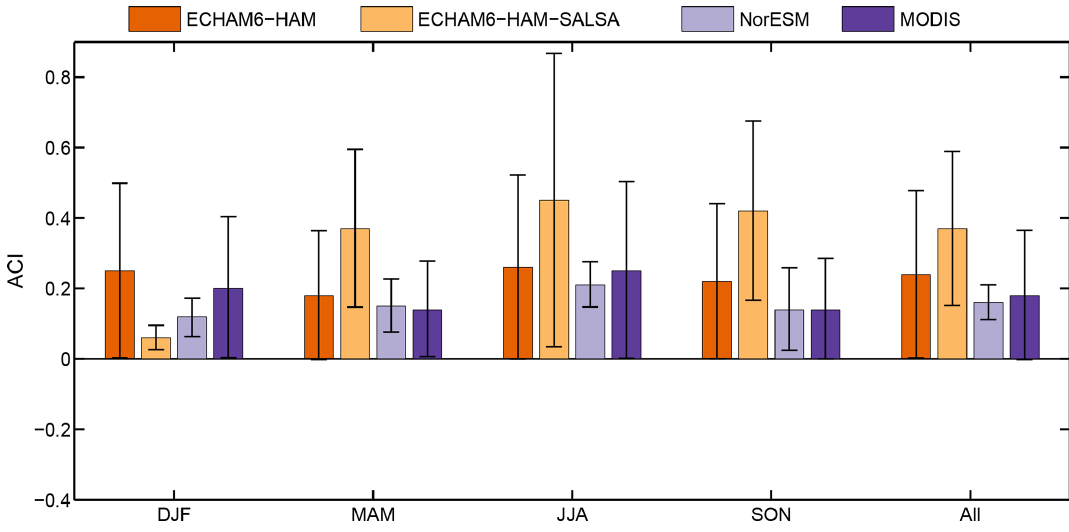
Figure 7. Global (over ocean only) estimates of the ACI CDNC computed as the changes in ln(CDNC) to ln(AI). CDNC values are derived from corresponding daily grid points of LWP and COT from MODIS observations and COSP-MODIS outputs following Bennartz (2007). ACI CDNC values are calculated by season and for the entire period (1 January 2008–31 December 2008). Uncertainty estimates are calculated as 95% confidence interval from the daily